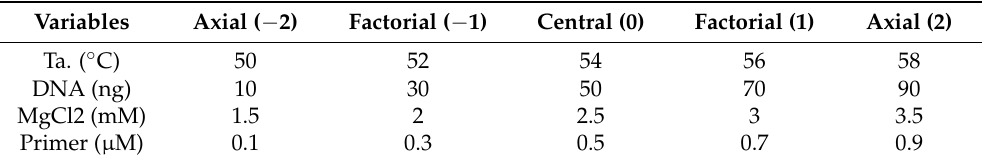
Table 3. Coded variables resulting from the experimental design for endpoint Multiplex- PCR